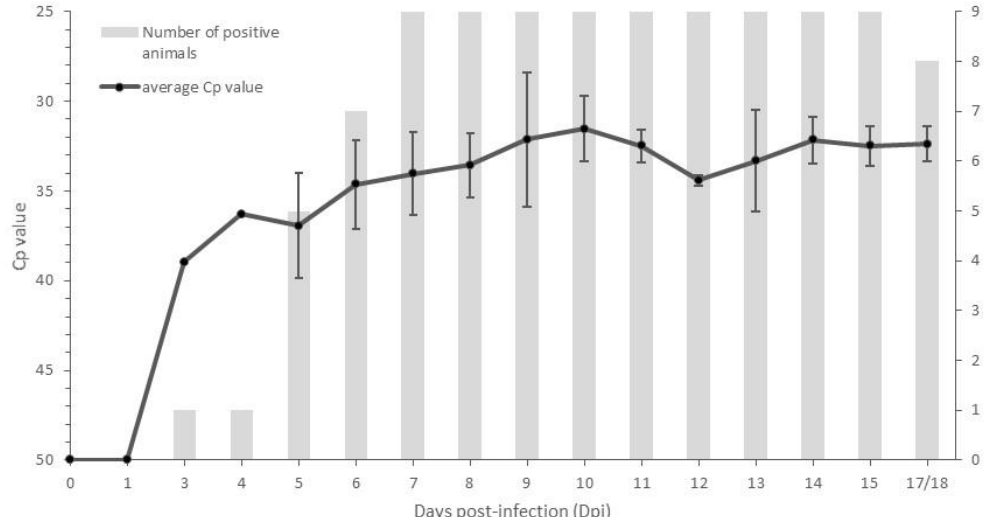
Figure 4. Control animals displaying skin nodules ( n = 9): average Cp of the positive blood samples (standard deviation is shown as error bars) and the number of animals with a PCR-positive status.